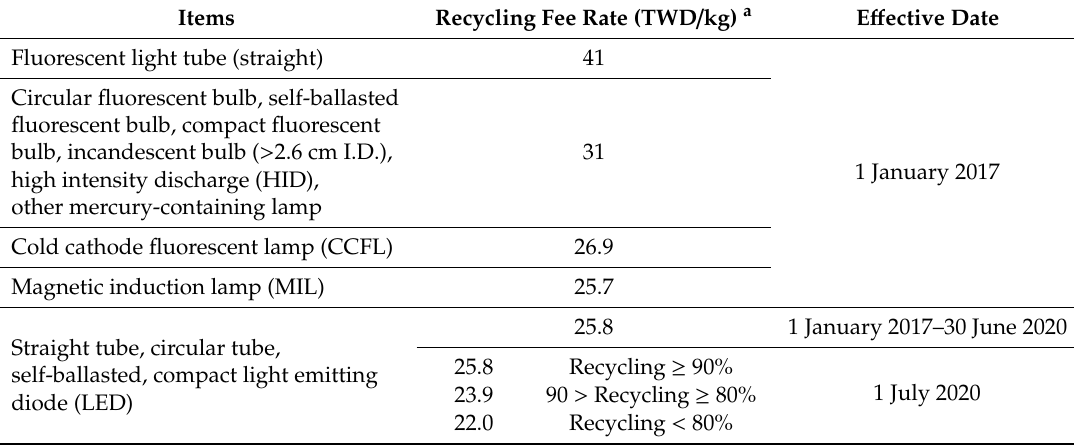
Table 3. Current recycling fee rates of recyclable lighting in Taiwan a